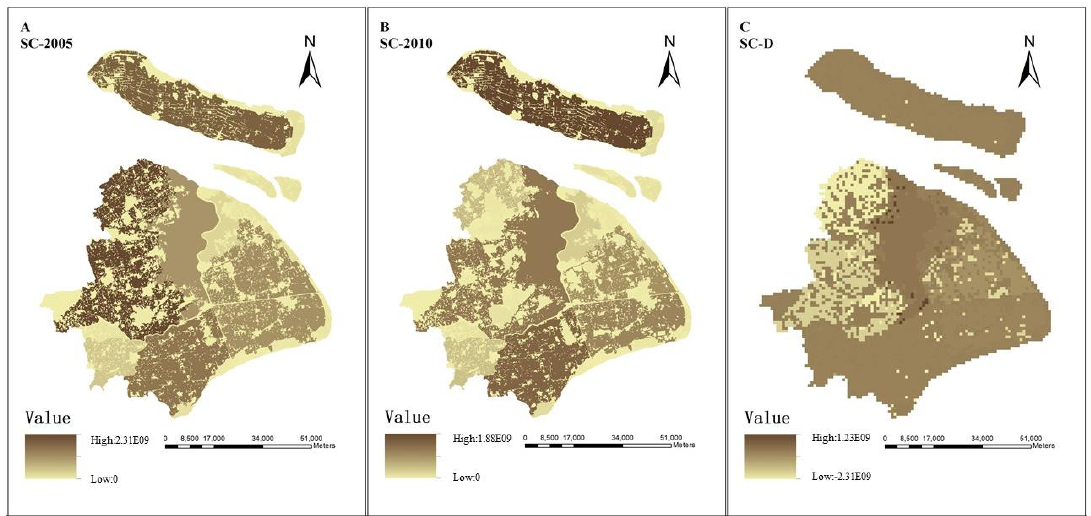
distribution of CS in 2005; ( B ) spatial distribution of CS in 2010; ( C ) spatial change of CS.